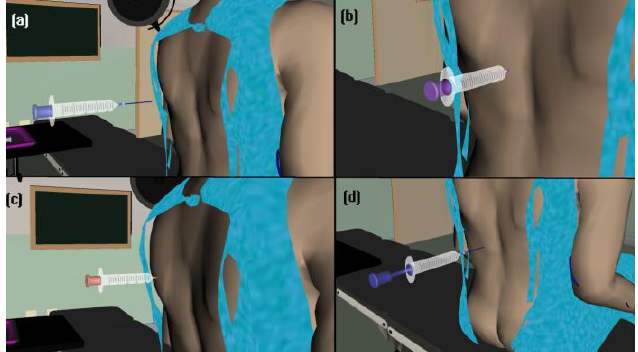
Fig. 8. Syringe piston changing color in the pleural liquid collection stage: (a) blue at procedure start, (b) purple when the right position is reached, (c) red when a wrong structure is hit and (d) blue again when the procedure is complete (needle removed from the patient body).